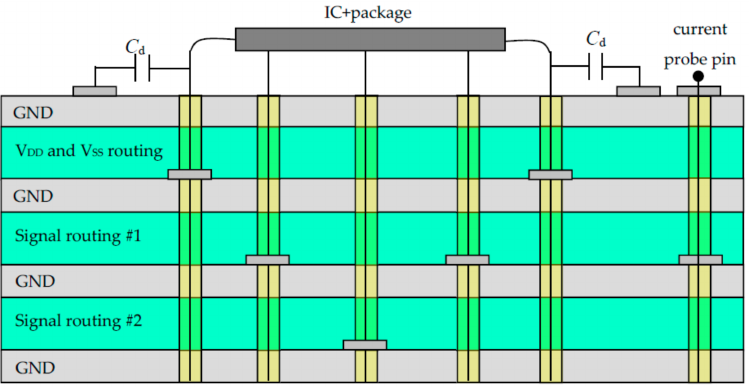
Figure 5. Stack layer of the designed test-board for the IC emission tests: the power traces are routed in separate layers, as well as signal traces coming from adjacent pins.